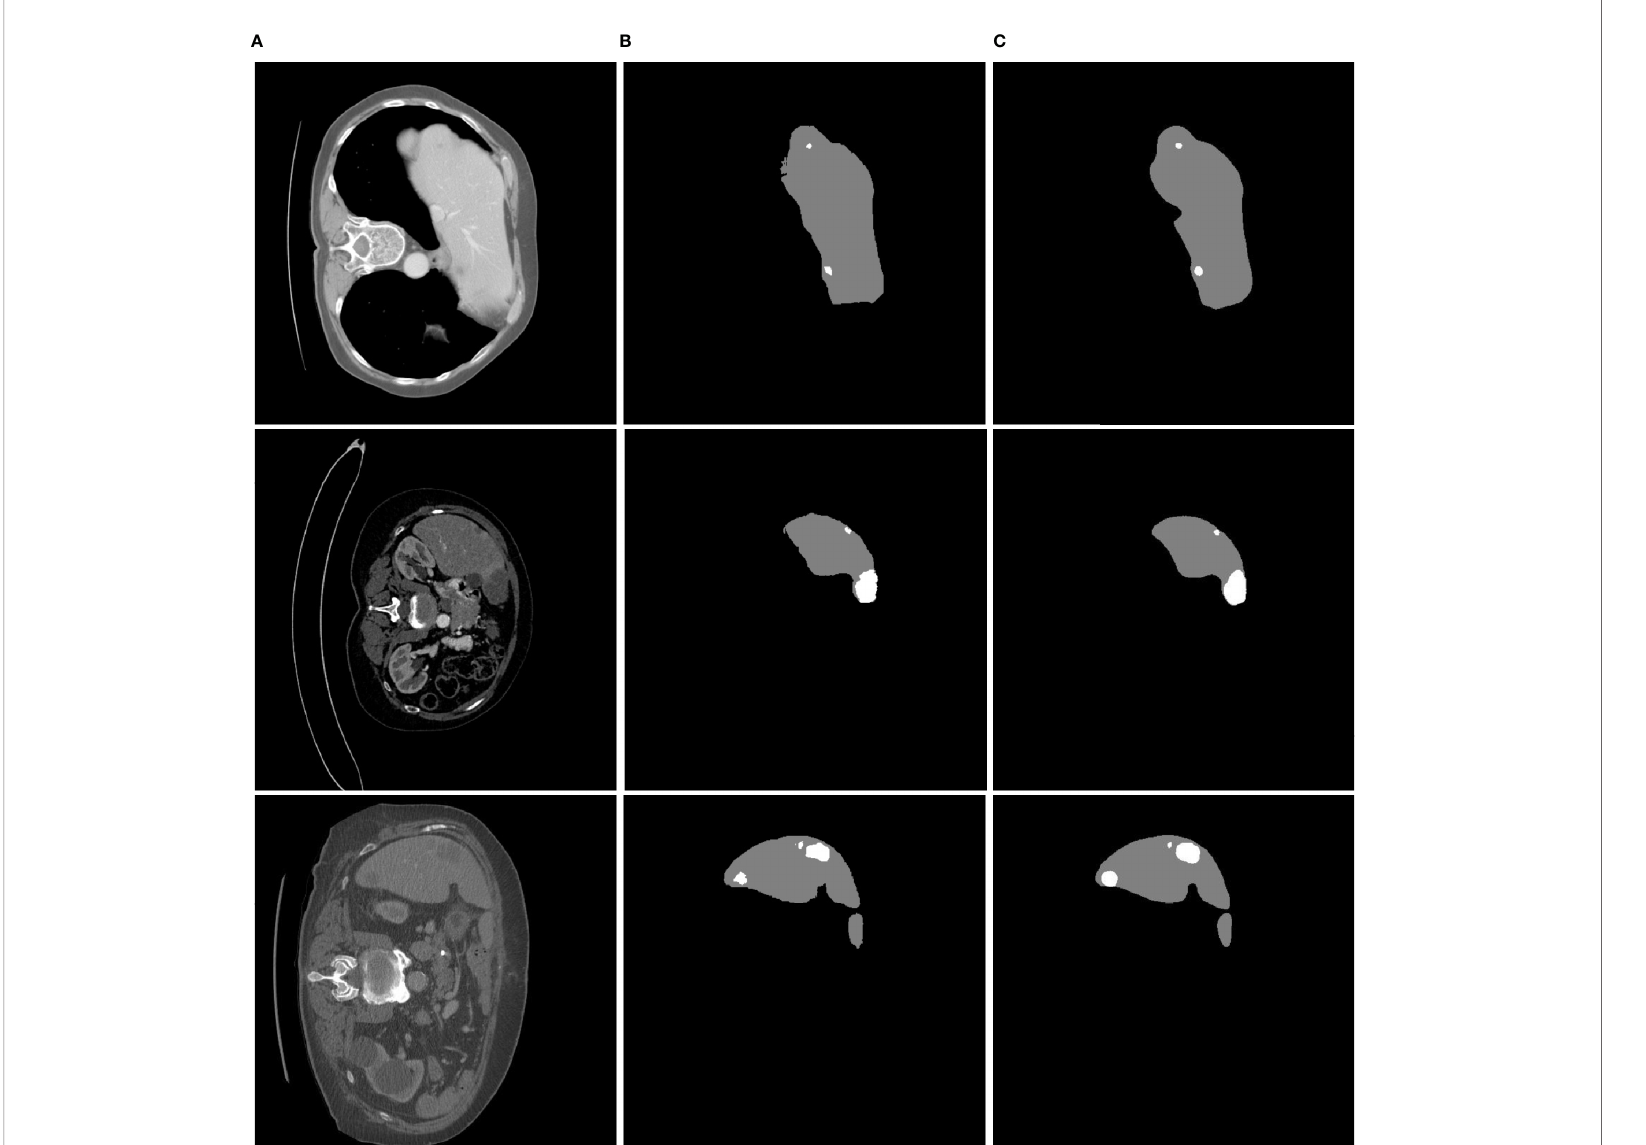
FIGURE 6 | Liver tumor segmentation results using MFU-net. (A) Raw image; (B) ground truth image; (C) segmented tumor